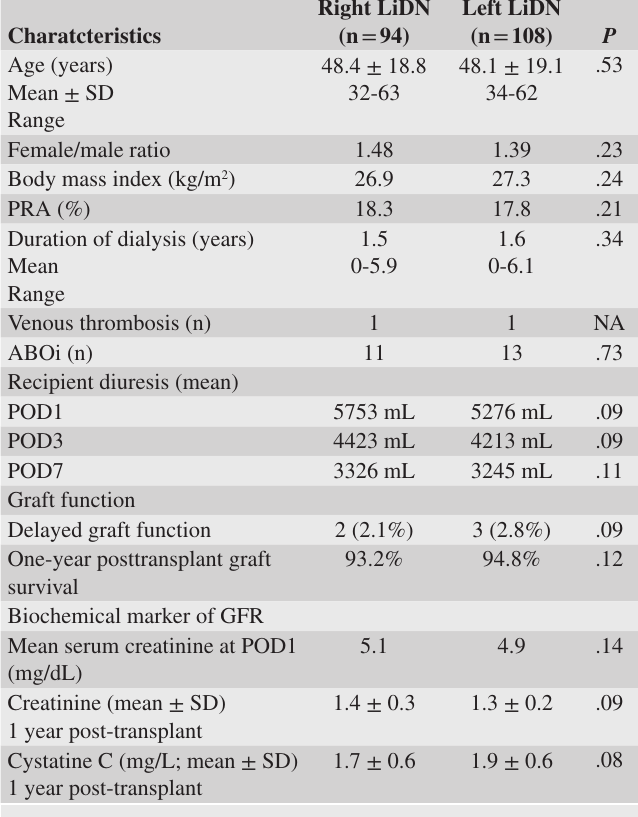
LiDN, living donor nephrectomy; SD, standard deviation; POD, postoperative day; PRA, panel reactive antibody; ABOi, ABO-incompatible; GFR, glomerular filtration